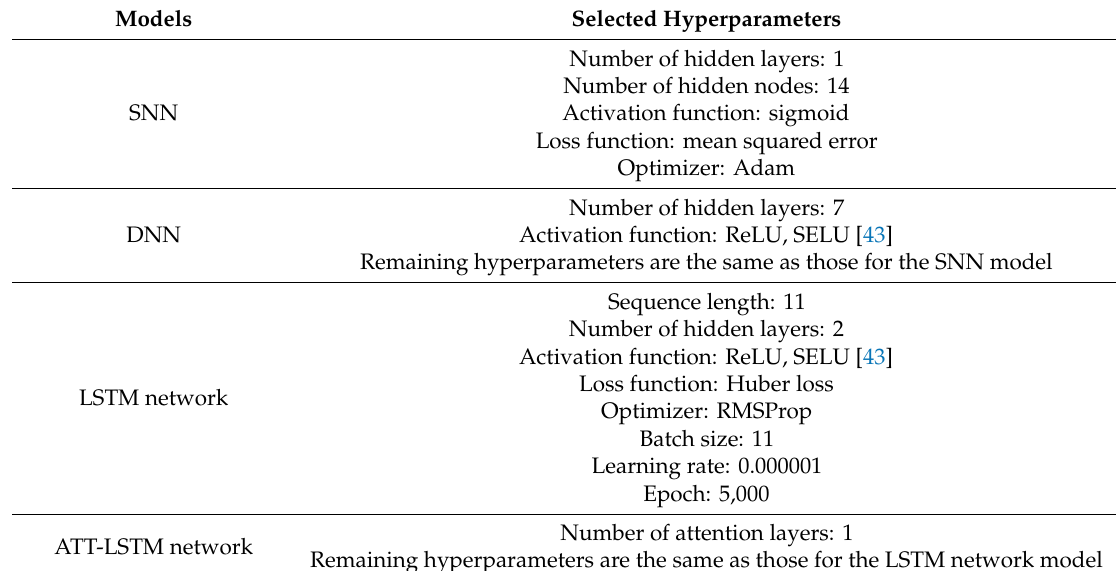
Table 2. Selected optimal hyperparameters for each deep learning model.